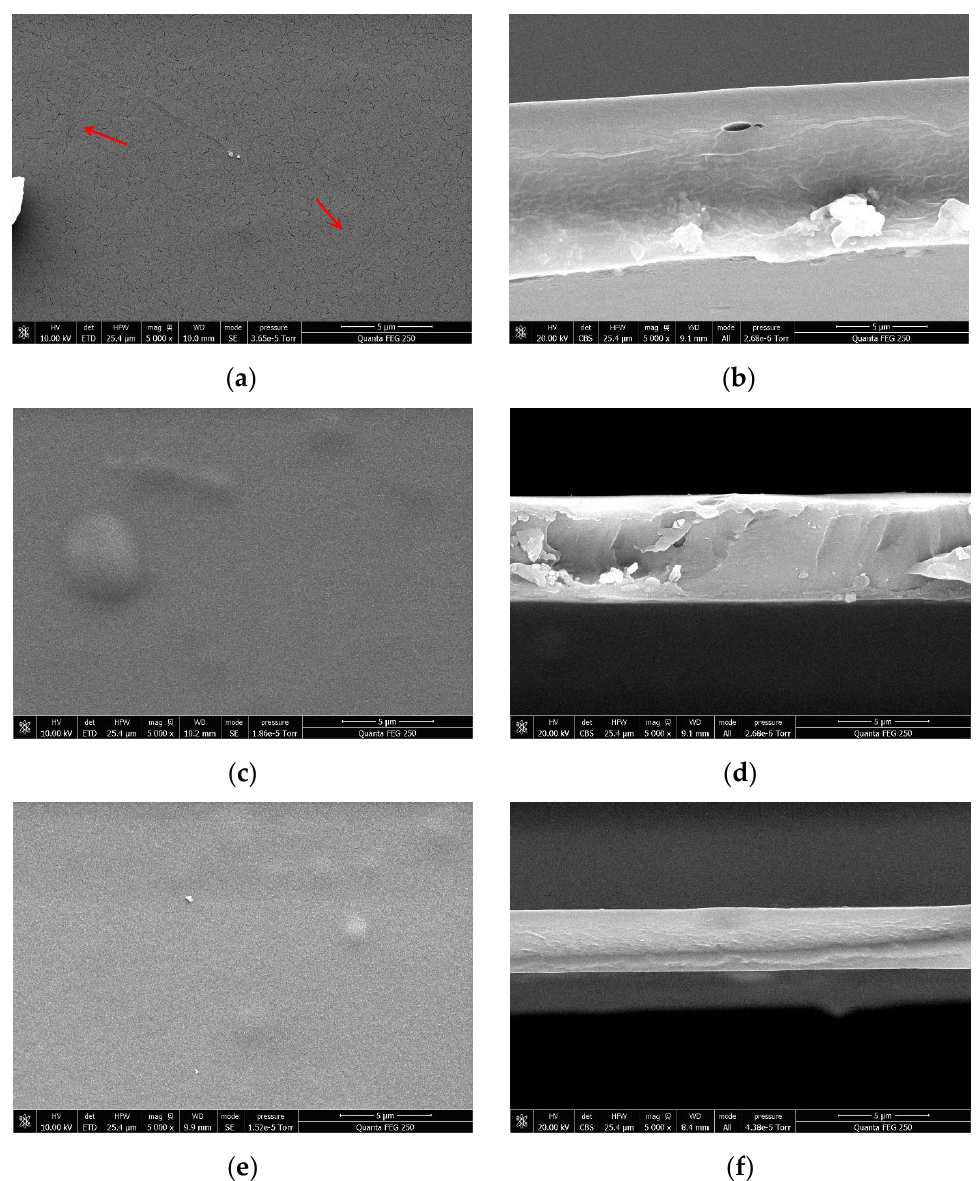
Figure 6. SEM micrographs with 5000x magnification of film composites: ( a ) chitosan (CH) top view, ( b ) CH Side view, ( c ) CH-CNC top view, ( d ) CH-CNC side view, ( e ) NCH-CNC top view, and ( f ) NCH-CNC side view.